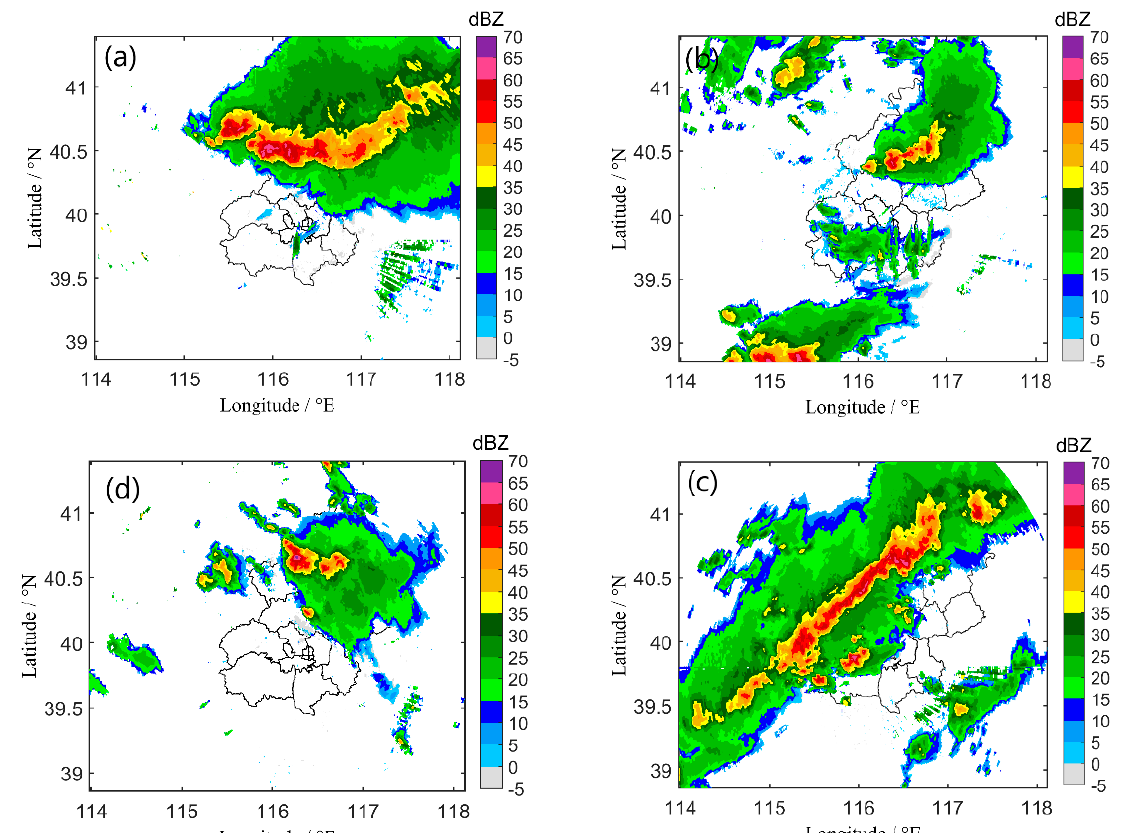
Figure 6. Composited S-band radar reflectivity factor Z (unit: dBZ) in Beijing. ( a ) Z at 20:00 BJT on